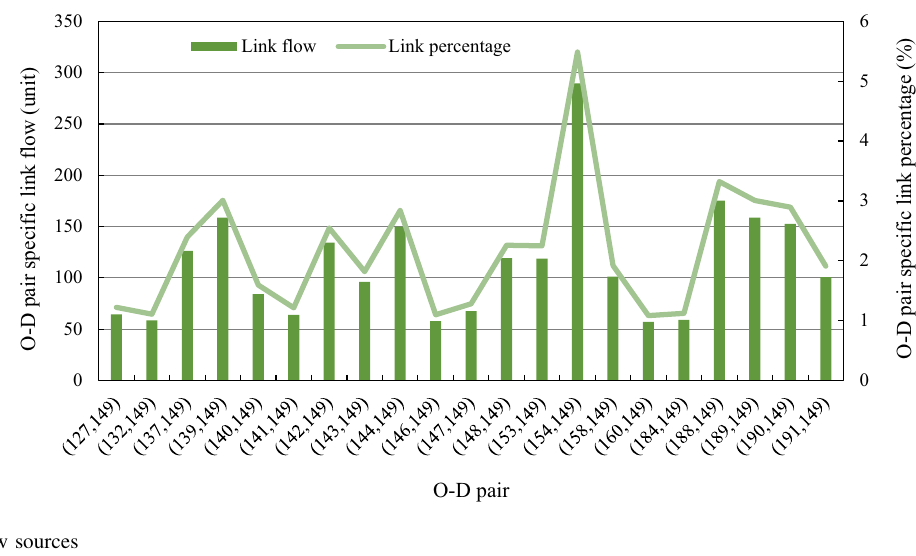
Fig. 13 Link flow